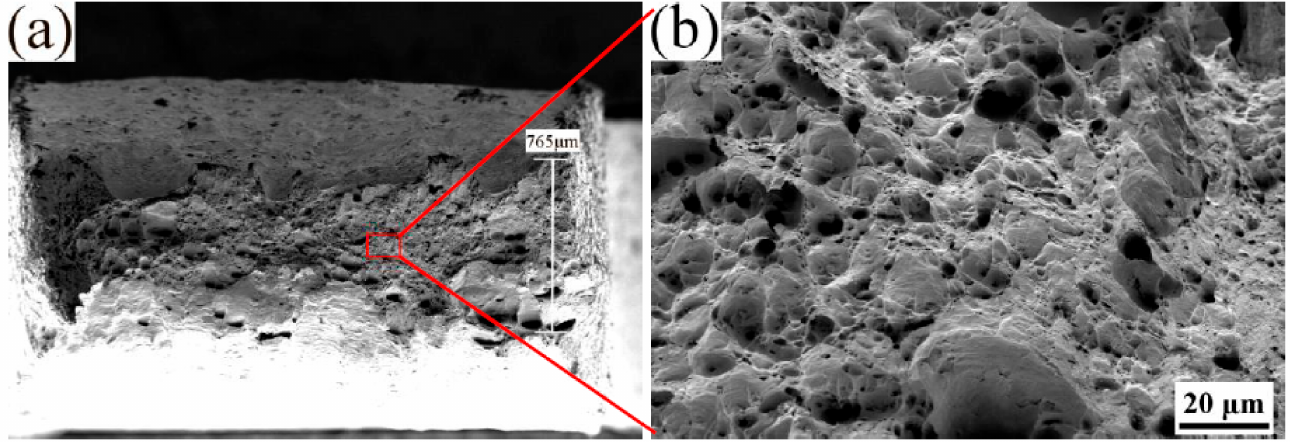
Figure 13. ( a ) Fracture morphologies of SLMed Ta made at 190 J/mm 3 after 1600 ◦ C heat treatments and ( b ) The enlarged image of the tough fracture within the red